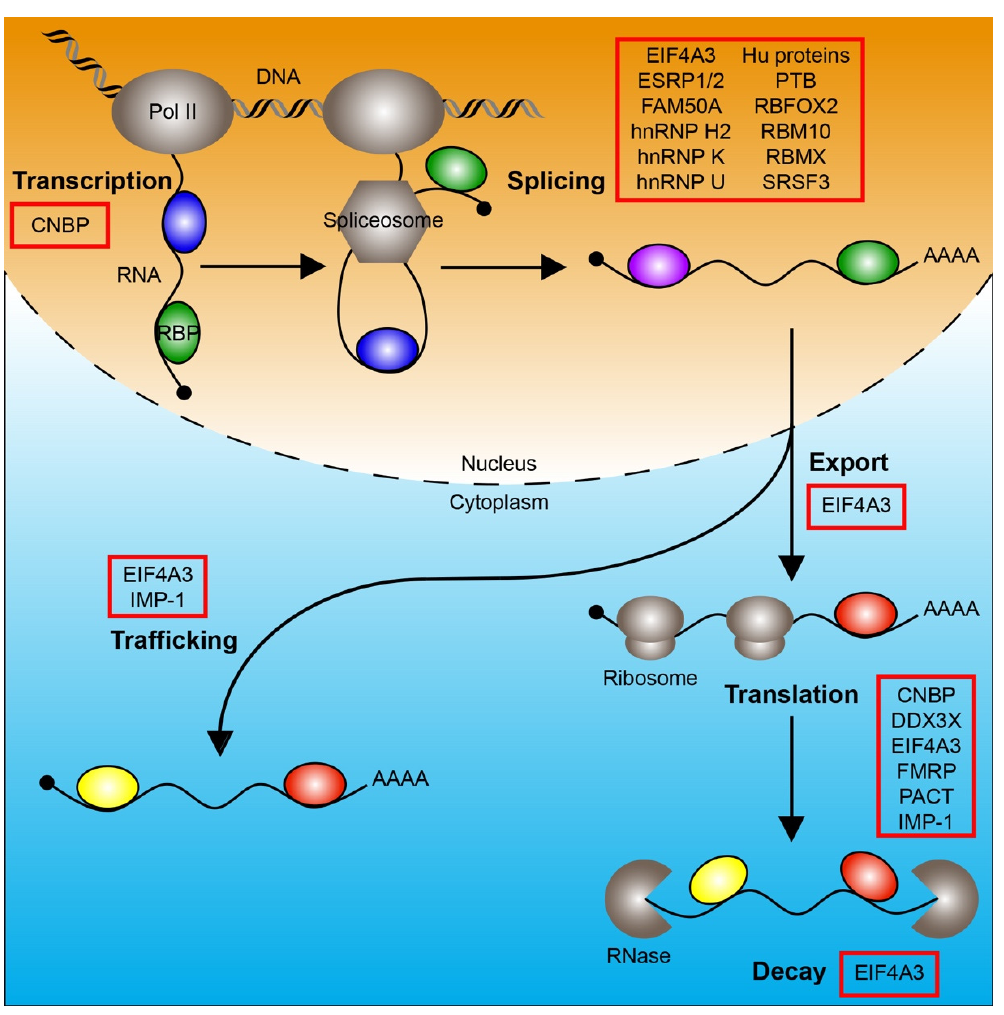
Figure 1. RNA-binding proteins regulate RNA metabolism. The processes of transcription, splicing, nuclear export, trafficking, translation and decay are depicted. RNA-binding proteins (colored ovals) that regulate these processes and have a role in mammalian neural crest and/or craniofacial development are boxed in red. Pol II, RNA polymerase II; RBP, RNA-binding protein.